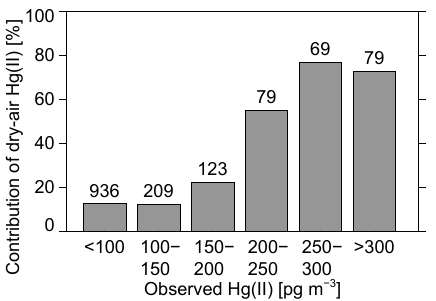
Figure 8. Modeled contribution of the dry-air Hg(II) tracer to ob- served Hg(II) concentrations during the NOMADSS aircraft cam- paign. The number of 2.5min observations points in each concen- tration bin is shown on top of the bars.